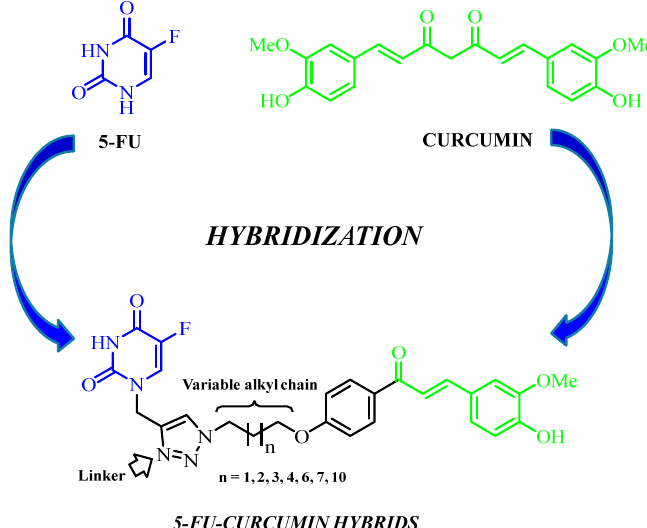
Figure 2. Design of 5-FU-Curcumin